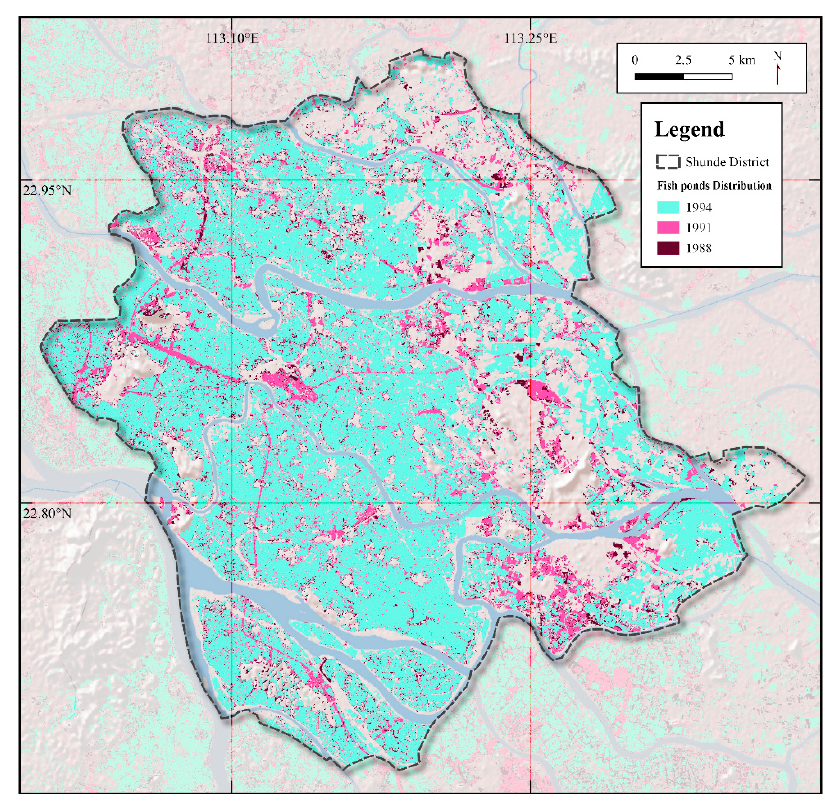
Figure 15. Spatial changes in fish ponds in Shunde District between 1988 and 1994.